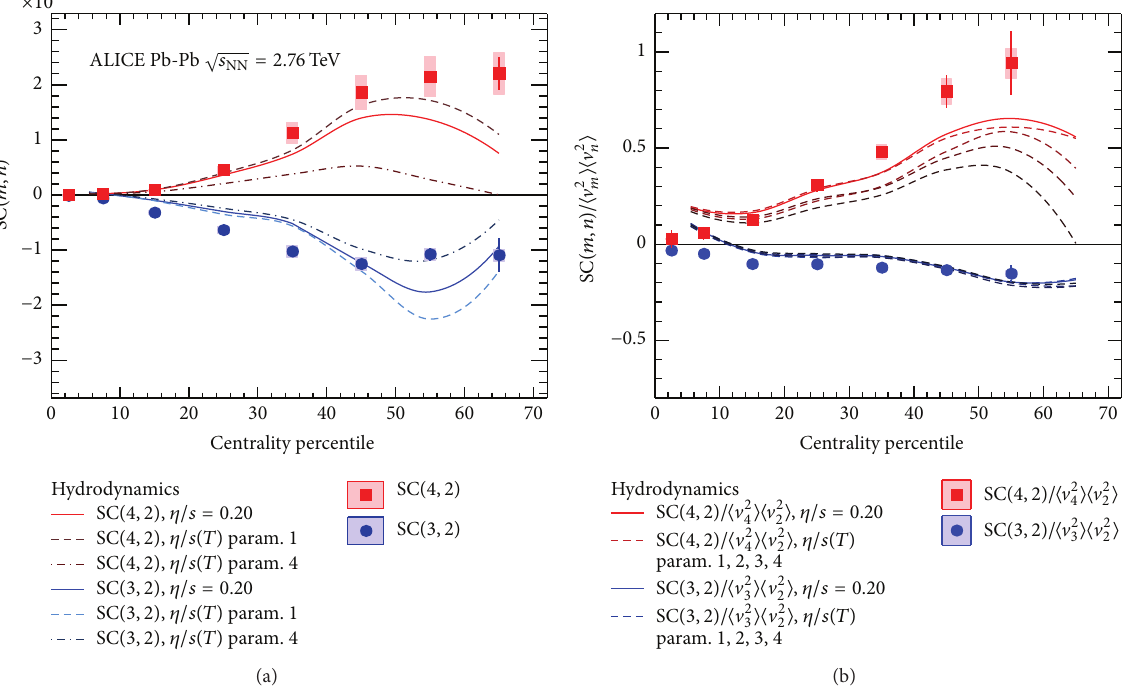
Figure 6: The centrality dependence of symmetric cumulants SC (4, 2) (red markers) and SC (3,2) (blue markers) at √𝑠 NN = 2.76 TeV Pb–Pb collisions. Figures are taken from